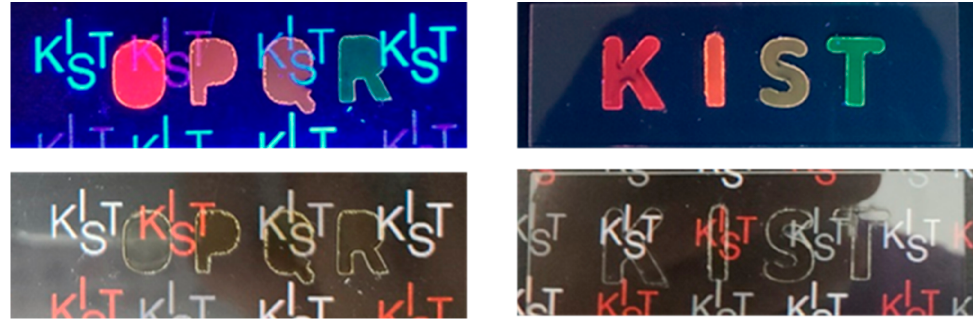
Figure 7. Alphabet-shaped “K-I-S-T” thin films on a slide glass prepared by varying the lanthanide doping ratio. Photographs were taken under 365 nm UV light irradiation ( top ) and under natural light ( bottom ).